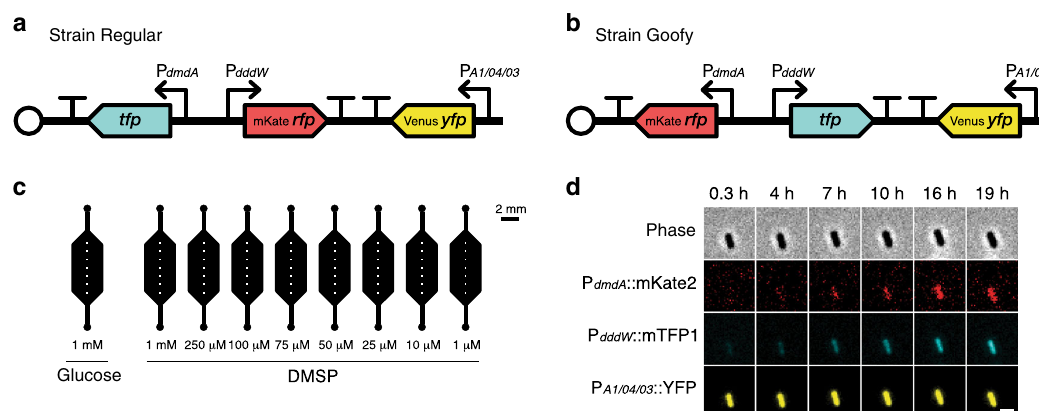
Fig. 1 Single-cell measurements of DMSP degradation pathway expression. a , b Plasmids transformed into R. pomeroyi DSS-3 contain three components: dmdA reporter (222 bp promoter region); dddW reporter (500 bp promoter region); and constitutive yfp expression (strong, synthetic promoter P A1/04/03 ). YFP signal was used as a proxy for plasmid copy number and metabolic activity. Transcriptional terminators (represented by T) were placed between promoter fusion cassettes to prevent transcriptional read-through. To control for spectral bias caused by fl uorescent protein choice (RFP or TFP), we constructed two R. pomeroyi reporter strains — Regular ( a ) and Goofy ( b ) — in which the colors of fl uorescent proteins fused to dmdA and dddW promoter regions were interchanged. Vector backbone: pBBR1MCS-2 with origin of replication pBBR1 (open circles). c Schematic of a single micro fl uidic device used for time-lapse DMSP experiments. Each time-lapse DMSP experiment used one micro fl uidic device containing nine observation chambers for parallel incubation of a single reporter strain (Regular or Goofy; a , b ) with different concentrations of DMSP. Glucose was used as negative control. White squares in each observation chamber represent the seven fi elds of view (200 μ m × 200 μ m) imaged at each time point. d Representative phase contrast and fl uorescence images of a single cell (strain Goofy) over time in the presence of 1 mM DMSP. Scale bar, 2 μ